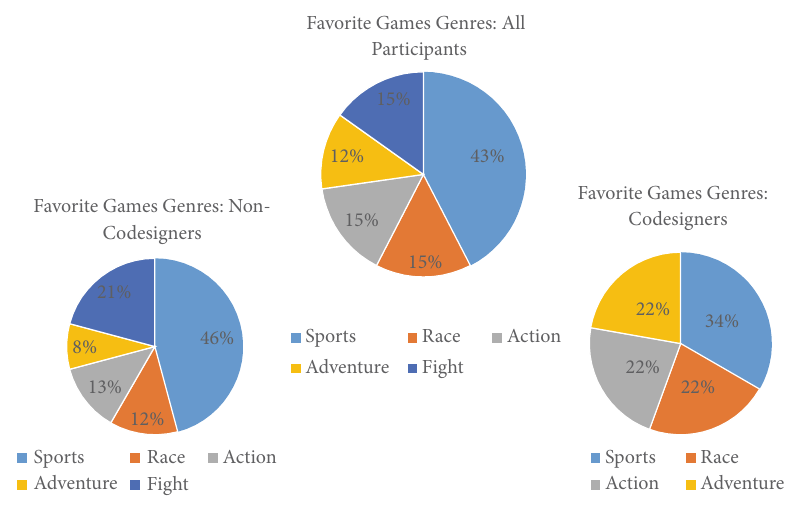
Figure 13: Favorite game genres among testers. Table 8: Pretest questionnaire for characterizing the player profiles, translated from Portuguese.